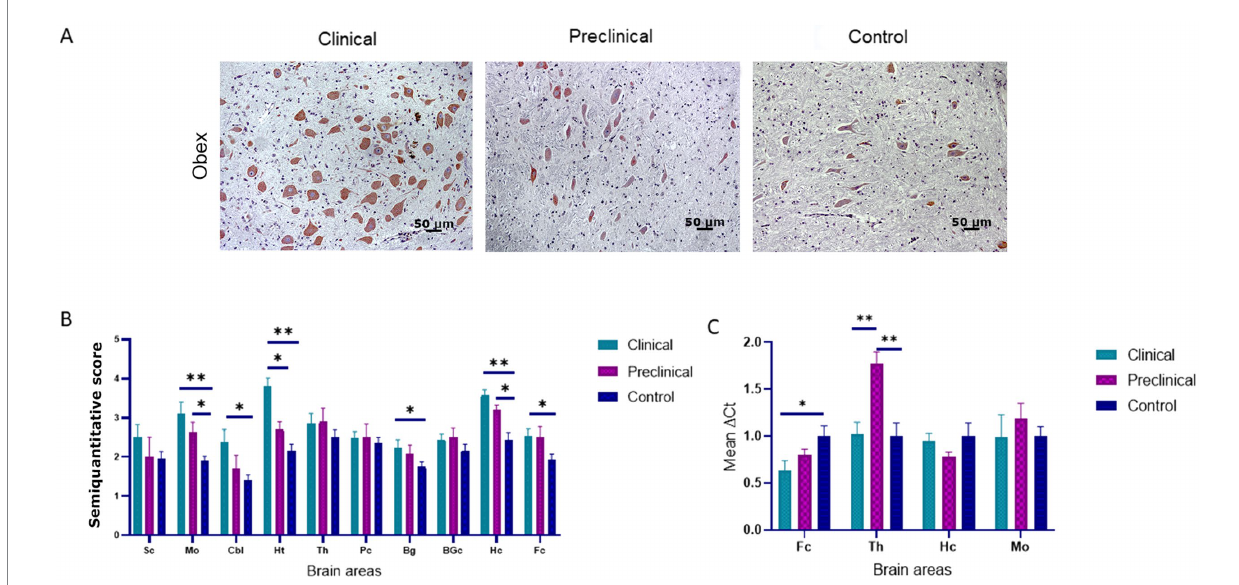
FIGURE 3 Protein disulfide isomerase (PDI) expression in clinical and preclinical scrapie-infected sheep and control sheep. (A) A strong intraneuronal labeling of PDI was observed in the medulla oblongata of clinical animals [pictures show the dorsal motor nucleus of the vagus nerve (DMNX)]. (B) PDI protein expression levels are more intense in clinical sheep when compared to controls in most brain areas. Expression levels of PDI protein in eight clinical, five preclinical and eight control animals were semi quantitatively evaluated using a scale of 0 (lack of immunostaining) to 5 (very intense immunostaining) in nine brain areas: [spinal cord (Sc), medulla oblongata (Mo), cerebellum (Cbl), hypothalamus (Ht), thalamus (Th), parietal cortex (Pc), basal ganglia (BG), cortex at the level of basal ganglia (BGc), hippocampus (Hc) and frontal cortex (Fc)]. Clinical sheep showed the highest levels of PDI in almost every brain area evaluated (* p < 0.05, ** p < 0.01, Mann–Whitney U test). (C) Gene expression of P4HB in frontal cortex, thalamus, hippocampus and medulla oblongata of clinical, preclinical, and control sheep. The results were normalized using the expression of SDHA and GAPDH housekeeping genes. The expression values were determined using the 2 −∆∆ Ct method. Mean scores between experimental groups were assessed using the one-way ANOVA test followed by the Bonferroni post hoc test (* p <